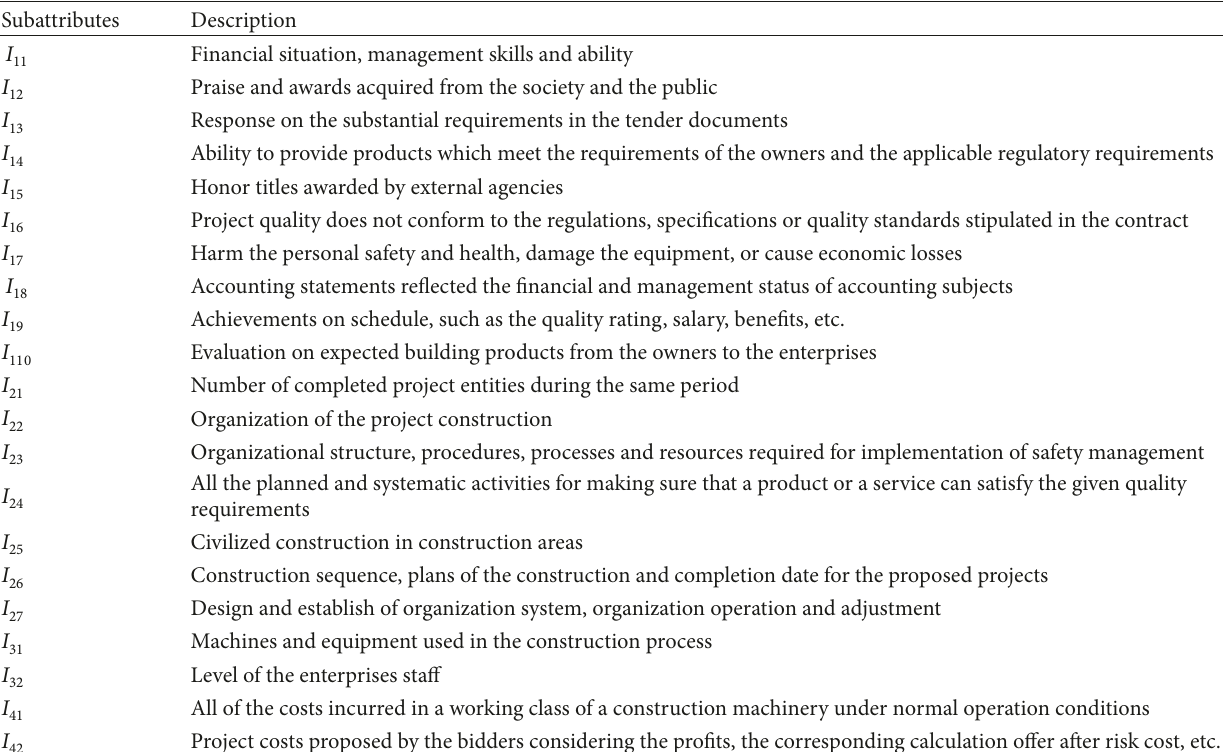
Table 1: A basic decomposition of competitive subattribute (Source from: [8–12, 23]).